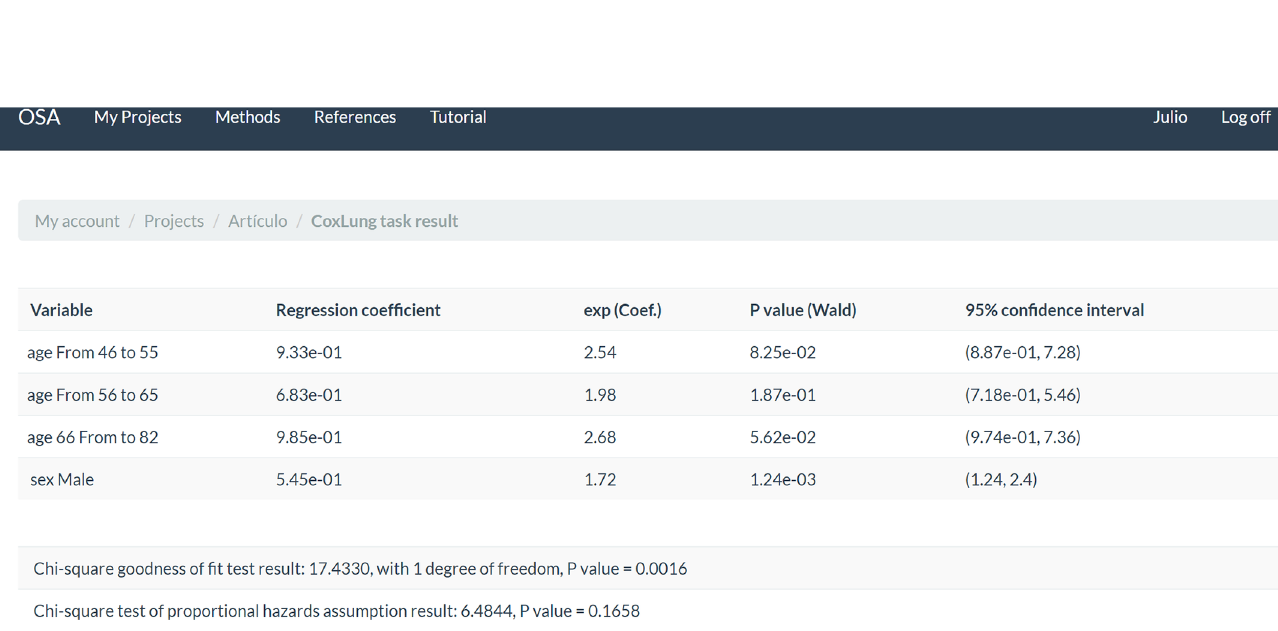
Fig 6. The Cox regression result as it is generated by the